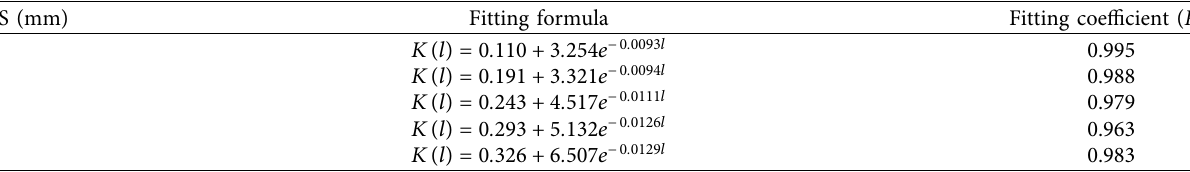
Table 7: Fitting relationships between K and rock size.